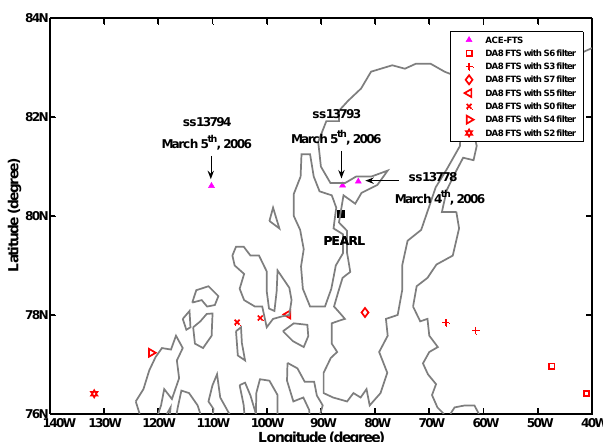
Fig. 2. Locations of simultaneous PARIS-IR and DA8 FTS mea- surements taken on 4 March 2006. Each measurement location is indicated using the ground location of the 18km altitude in the FTS slant path (calculated geometrically) and is labelled with a red symbol. The shape of red symbol indicates the optical filter used for the DA8 FTS measurement. During each DA8 FTS measure- ment, PARIS-IR recorded the entire spectral region from 750 to 4400cm − 1 . In addition, the tangent point locations of the ACE-FTS occultations made on 4 and 5 March 2006 are indicated. Location of PEARL is shown with a black solid